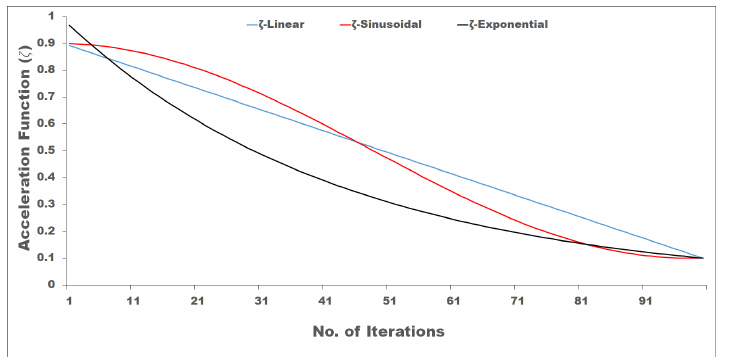
Figure 5. Linear, Sinusoidal and Exponential variation of acceleration function ( ζ ) with respect to iterations.